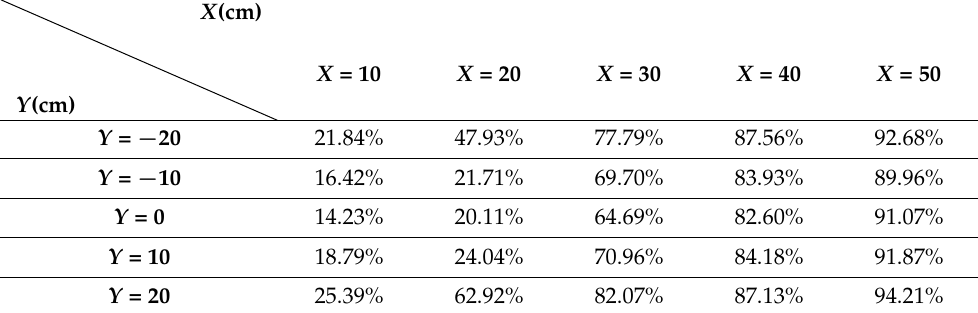
Table 5. Energy resolutions at the source positions ( X , Y ) obtained from